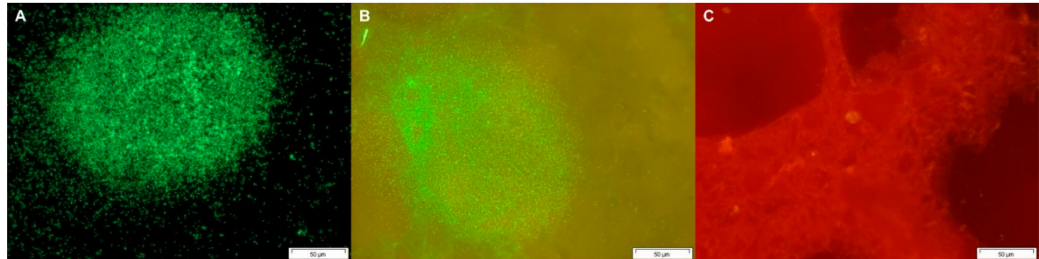
Table 4. Bacterial growth and biofilm formation of L. monocytogenes on polyester and stainless steel after 72 h of incubation under high relative humidity conditions of ≥ 90%. (Concentration in ppm)